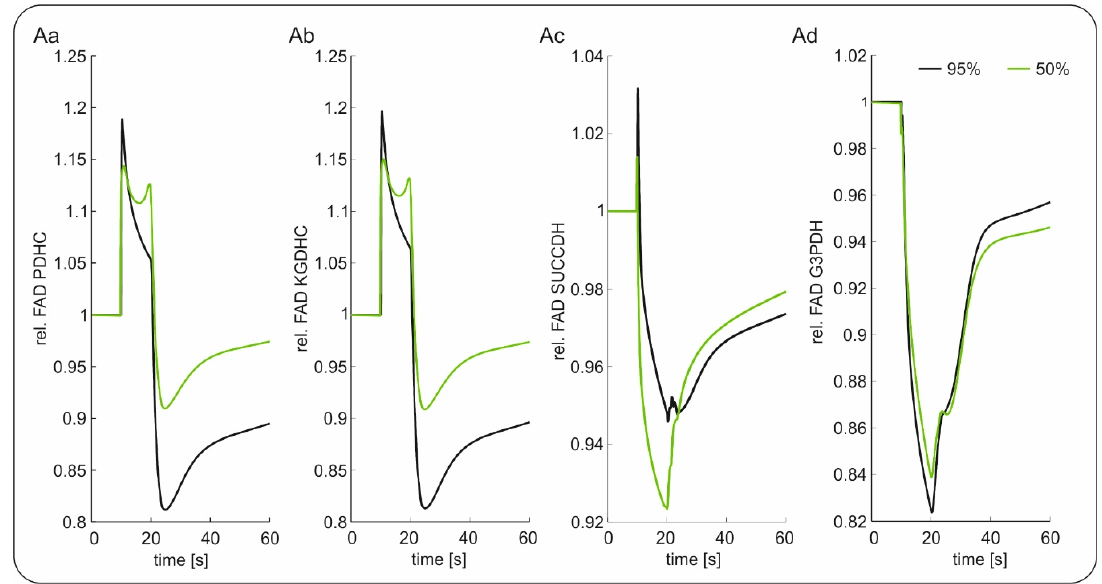
Figure 4. Modeling of relative changes in Flavin adenine dinucleotide (FAD) signaling during electrical stimulation with 95% oxygenation (black) and 50% oxygenation (green); ( Aa ) FAD signal of pyruvate dehydrogenase (PDHC); ( Ab ) FAD signal of α -ketogluterate dehydrogenase (KGDHC); ( Ac ) FAD signal of succinate dehydrogenase (SUCCDH); ( Ad ) FAD signal of mitochondrial glycereol-3-phophate dehydrogenase (G3PDH).